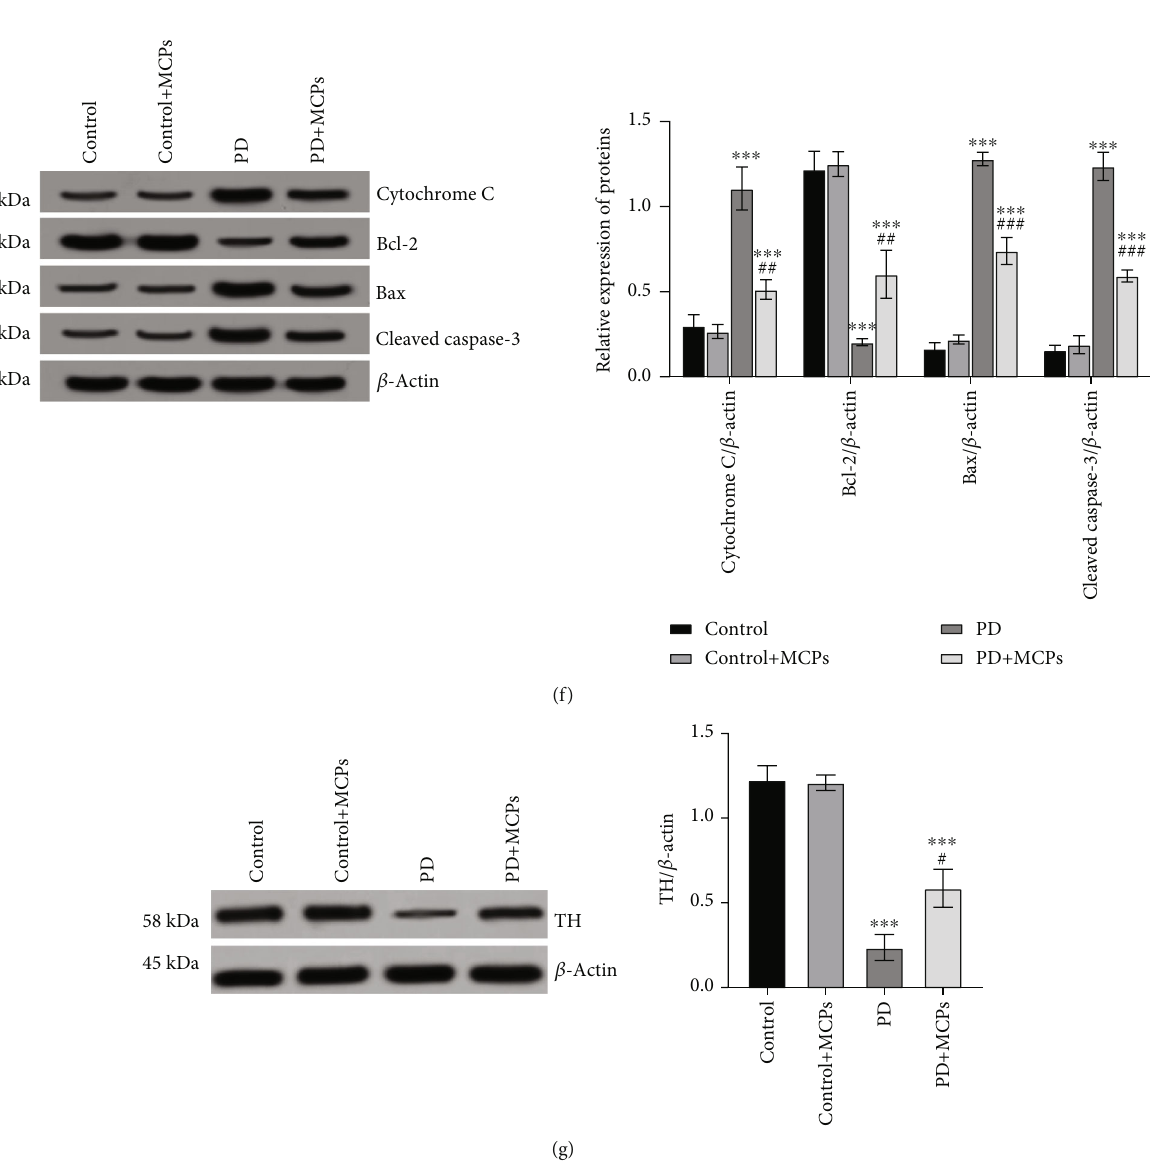
Figure 3: MCPs reduce the in fl ammation, oxidative stress, and apoptosis of PD induced by MPTP. (a, b) Expression of proin fl ammatory cytokines TNF- α and IL-1 β in striatum tissue homogenate. (c – e) Expression of oxidative stress-related factors MDA, SOD, and GSH in striatum tissue homogenate. (f) The expression levels of oxidative stress-related protein Cytochrome C and apoptosis-related proteins Bcl- 2, Bax, and cleaved Caspase-3 in striatal tissue homogenate. (g) Tyrosine hydroxylase (TH) protein level in striatum tissue homogenate. Compared with Control group (Control+MCPs group), ∗∗∗ P < 0 : 001 , compared with PD group, ## P < 0 : 01 , ### P < 0 : 001